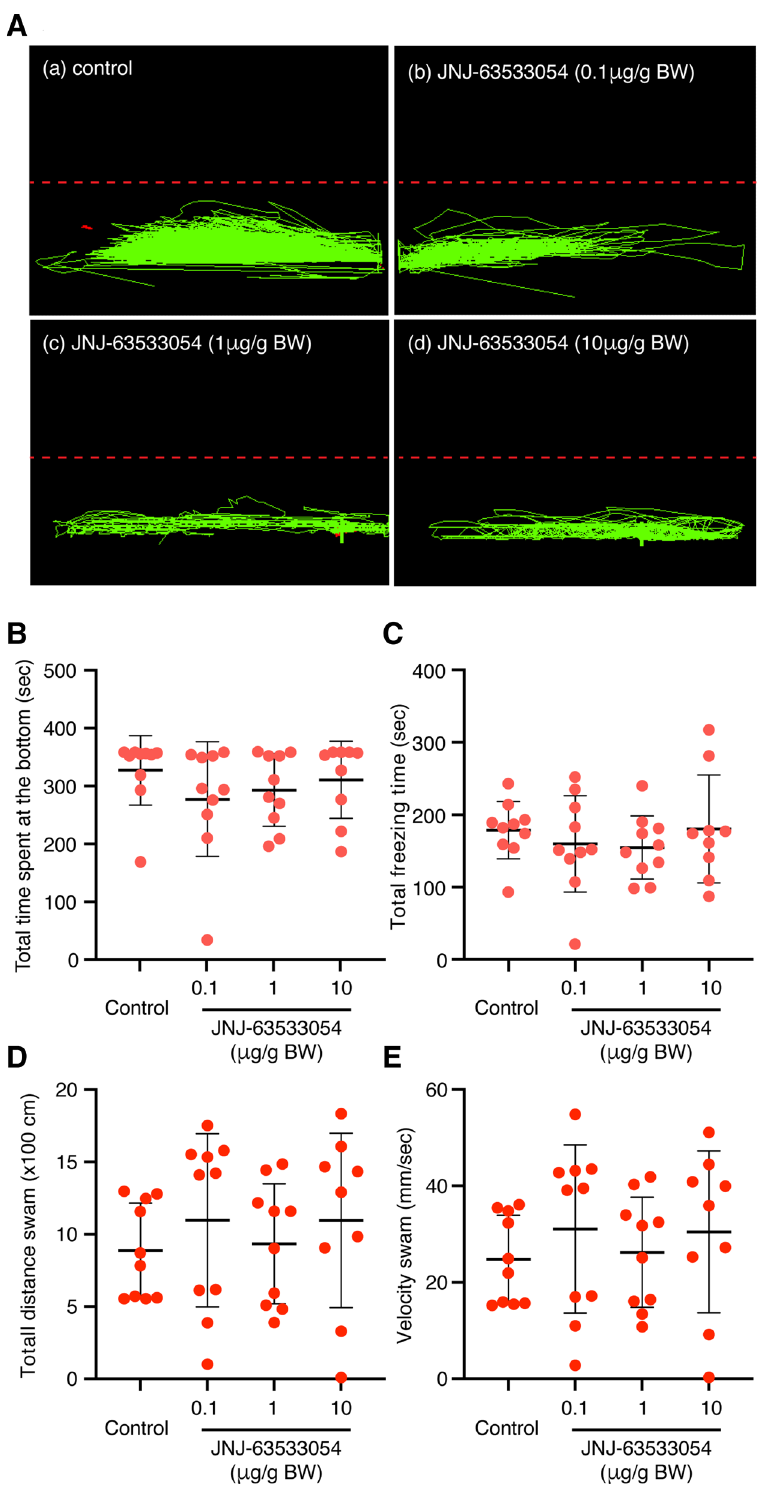
Figure 4. Effect of GPR139 agonist (JNJ63533054) on alarm substance-induced fear response. ( A ) Representative side-view video tracking of swimming behaviour at 30 min after administration of GPR139 agonist ( b , 0.1 µg/g; c , 1 µg/g; d , 10 µg/g body weight, BW) and subsequent alarm substance (AS) administration. However, there were no significant differences in AS-induced fear responses including the total time spent ( P = 0.4789, B ), total freezing time ( P = 0.6826, C ), total distance swam ( P = 0.7077, D ), and swimming velocity ( P = 0.6975, E ) at the bottom of a tank among GPR139 agonist treated and control